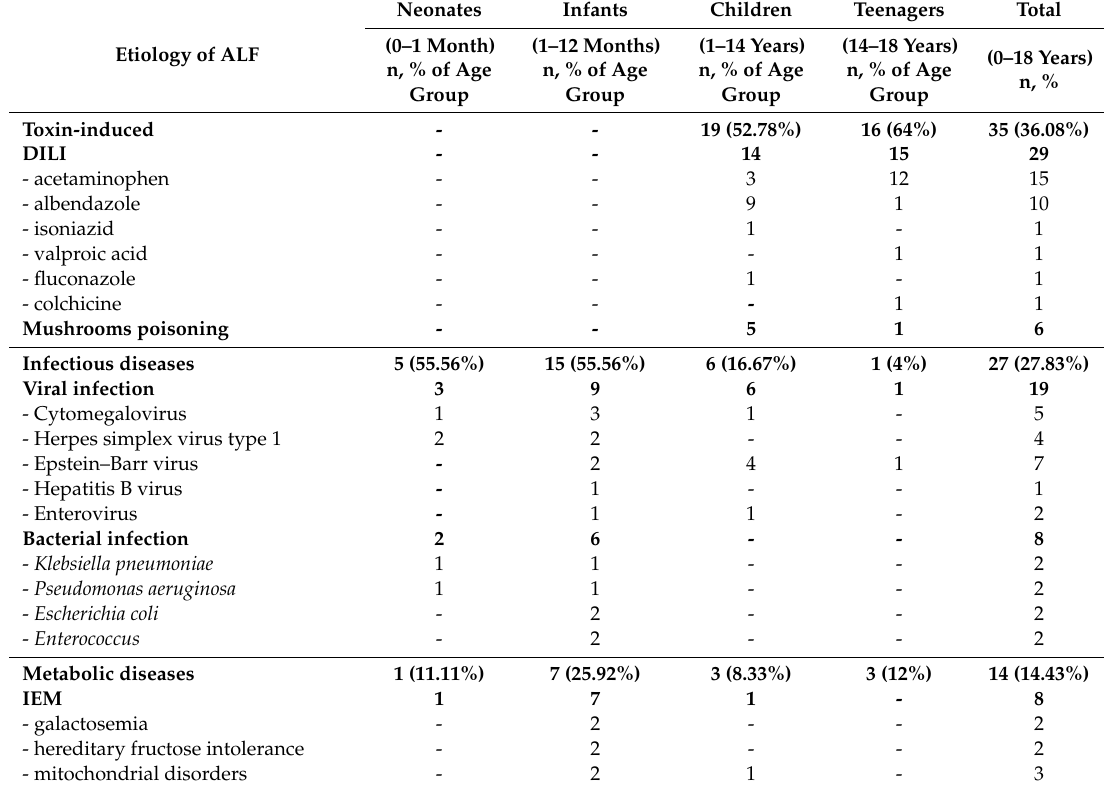
Table 2. ALF etiology in children by age